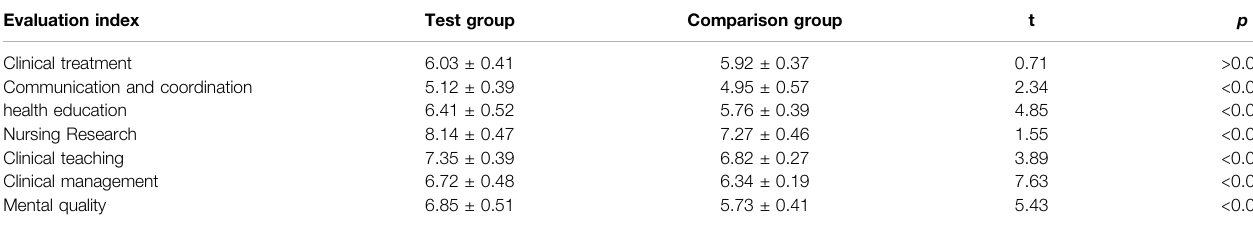
TABLE 4 | Results of emergency clinical ability of the two groups after 2 weeks of teaching.